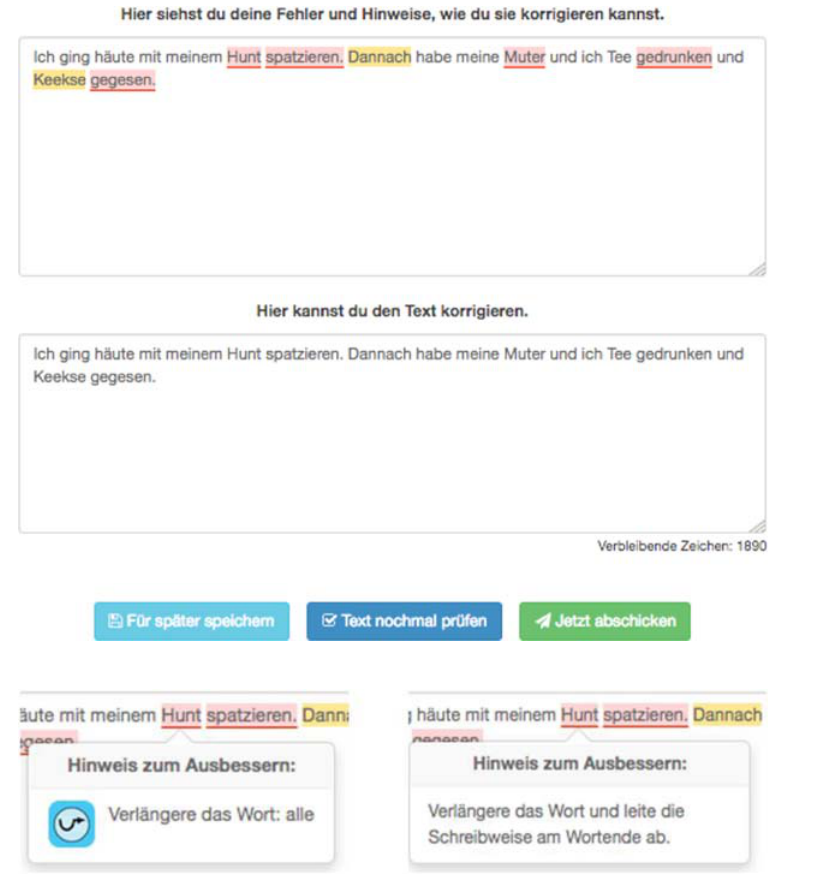
Figure 8. Feedback example with FRESCH (left) and general feedback